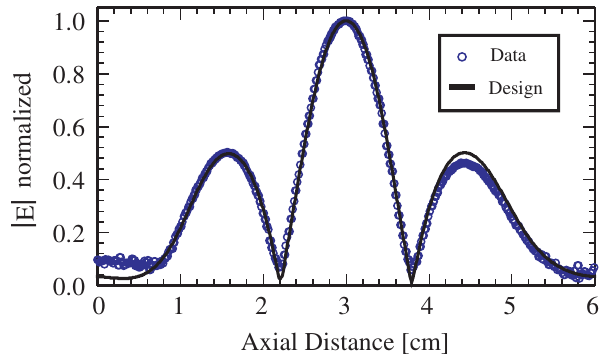
FIG. 11. Broad S measurement showing all observed reso- 11 nances of the PBG structure and mode launcher. The operating mode is the second from the right, at 11.43